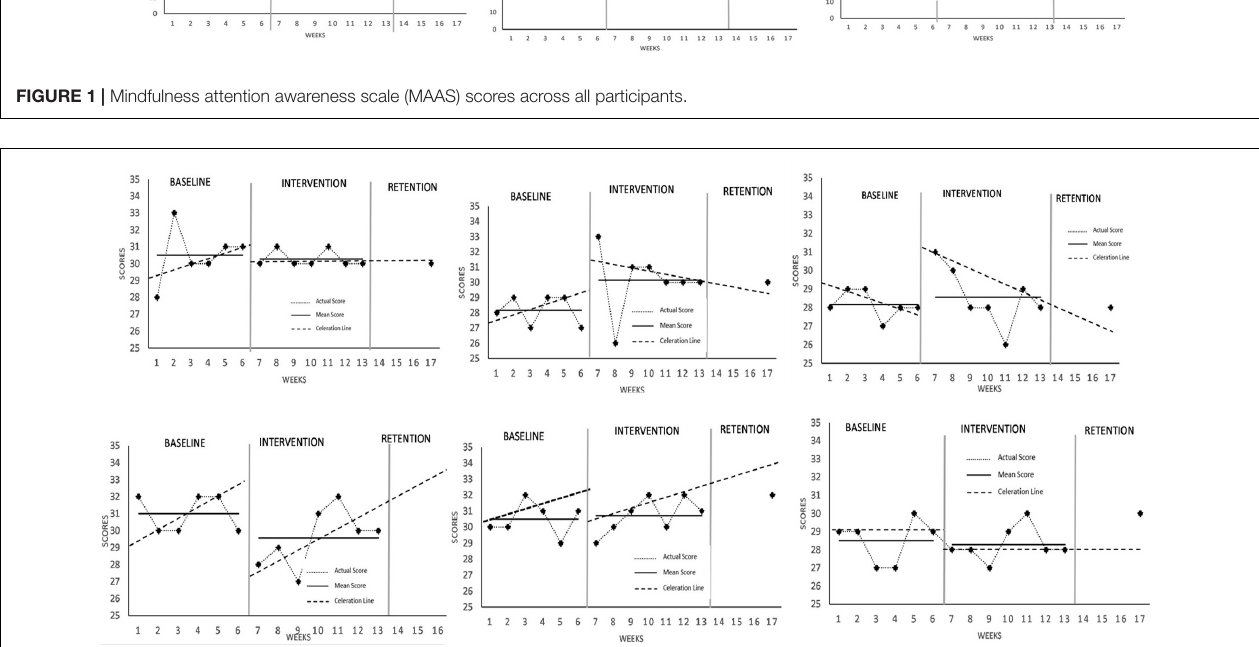
FIGURE 2 | Acceptance and action questionnaire II (AAQ-II) scores across all